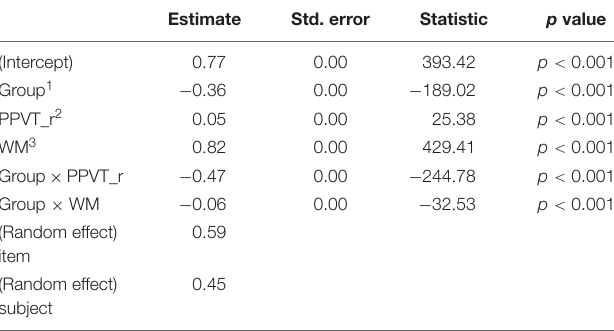
TABLE 5 | Regression results for individual